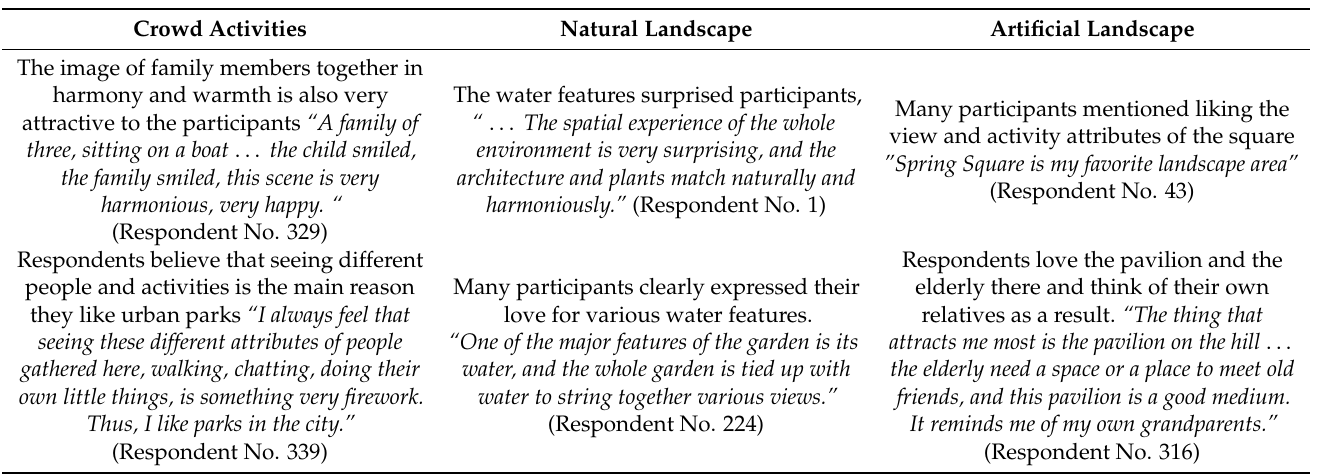
Figure 6. Emotion coding diagram. Table 6. Young adults’ favorite landscape types and Table 6. Young adults’ favorite landscape types and descriptions.